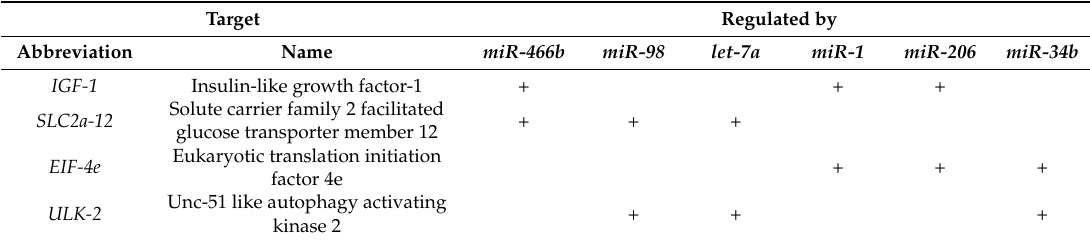
Figure 1. Representative image for in silico network analysis of the possible gene targets of the 8 altered miRNAs based on online databanks. Red nodes present miRNAs, blue nodes mark the predicted targets. Dark blue nodes label the target genes with ≥ 3 miRNA connections. Edges (gray lines) between nodes represent predicted miRNA–target interactions. ( a ) and ( b ) panels are presented in a magnified manner to help better perceive them. Table 5. Selected target genes indicating their miRNA connections by plus sign (+).